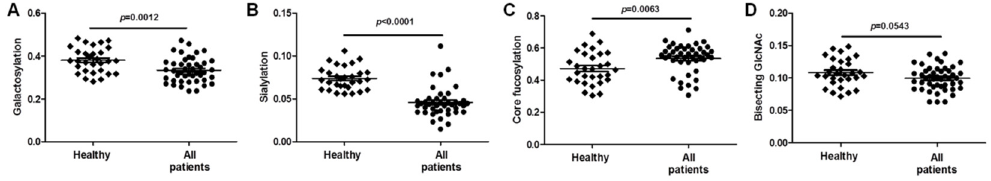
Figure 4. Aberrance of immunoglobulin G (IgG) glycosylation in serum of rheumatoid arthritis (RA) patients compared with healthy controls. IgG glycosylation in serum of patients with RA is different compared with healthy controls. Changes were also observed between patients with three various rheumatoid factor (RF) levels and healthy controls for total galactosylation ( A ), sialylation ( B ), core fucosylation ( C ), and bisecting GlcNAc ( D ). A two-tailed Student’s t-test comparison was performed between the healthy controls and patients, and patients with three RF levels. Error bar indicates standard deviation (ns, no significance; p < 0.05 indicated statistical significance).